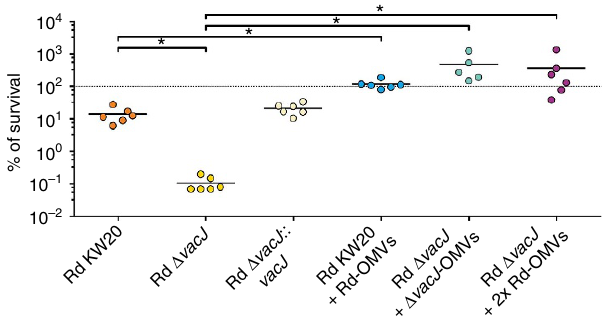
Figure 7 | OMVs increase the serum resistance of H. influenzae . Serum bactericidal assays were used to determine the serum resistance of Rd KW20, Rd D vacJ , and Rd D vacJ :: vacJ to normal human serum. Groups tagged with ‘ þ Rd-OMVs’, ‘ þ D vacJ -OMVs’, and ‘ þ 2x Rd-OMVs’ indicate assays, where Rd KW20 or Rd D vacJ OMV preparations were added to corresponding assays using respective physiological final in vitro concentrations or a twofold higher concentration (2 (cid:3) Rd-OMVs). For details please see the respective method section (serum bactericidal assay). Horizontal bars highlight the mean percentage of survival of each group ( n ¼ 5–6 biological replicates). The dotted line indicates 100% survival. Significant differences between the data sets are marked by asterisks ( P o 0.05; one-way ANOVA followed by Sidak’s multiple comparison post